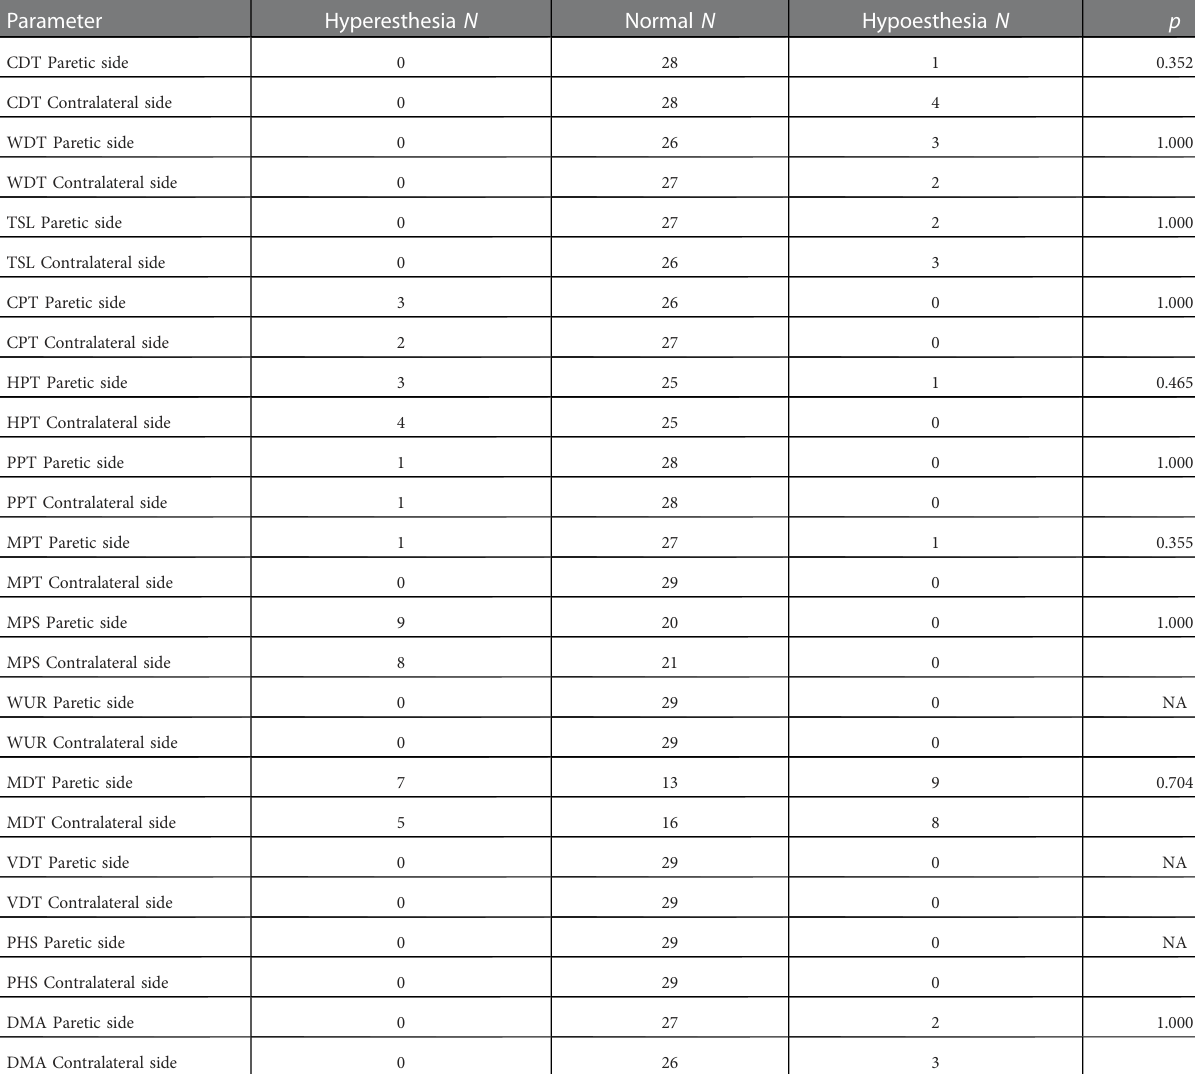
TABLE 2 Absolute number of hemifaces with increased (hyperesthesia), normal, and decreased sensory function (hypoesthesia) a . Parameter Hyperesthesia N Normal N Hypoesthesia N CDT Paretic